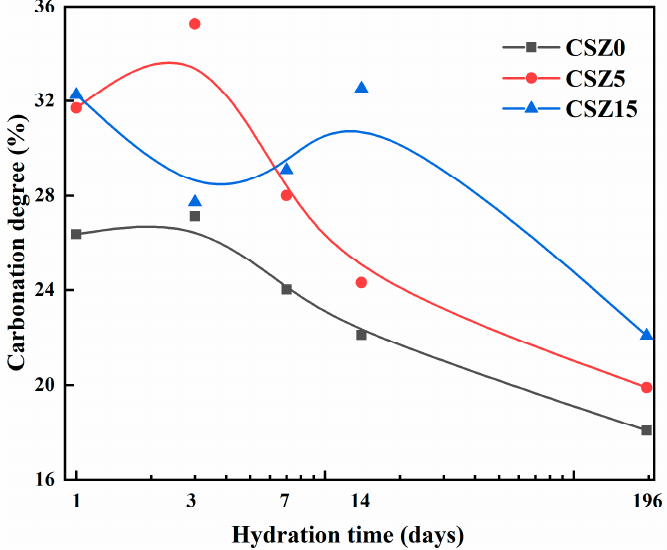
Figure 8. Carbonation degree of CSZ0, CSZ5, and CSZ15 specimens after different hydration time and then 2 h carbonation.